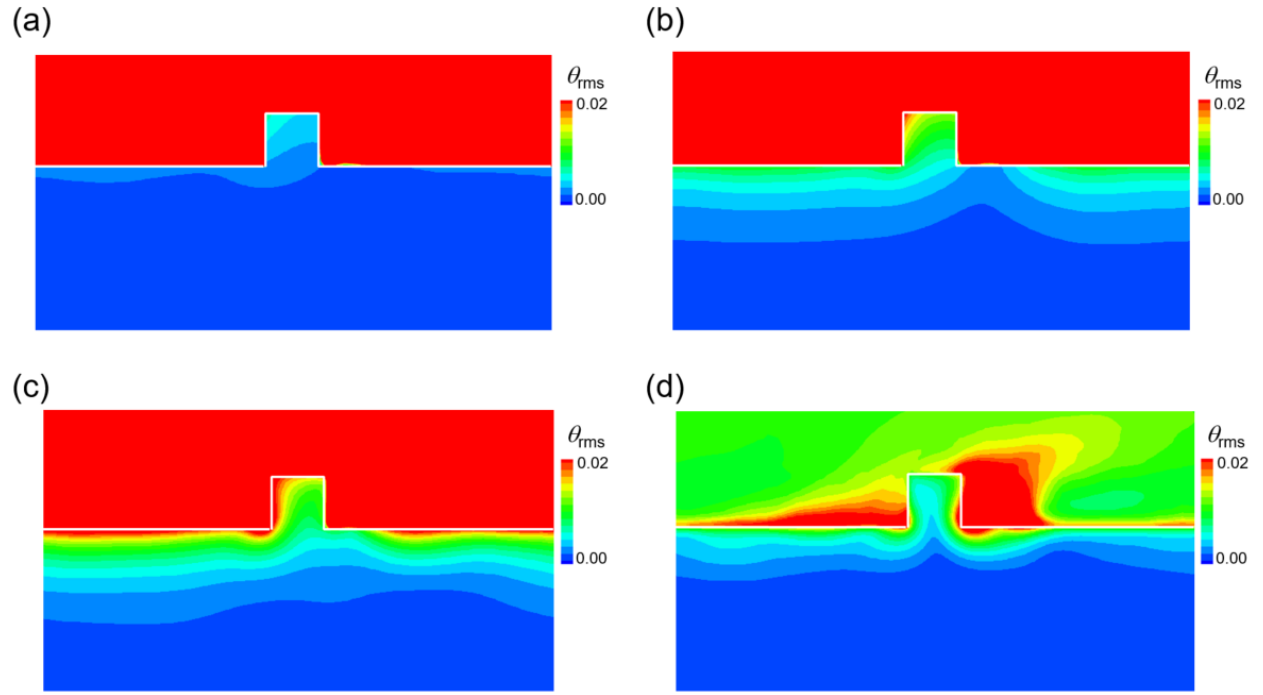
Figure 8. Temperature fluctuations ( θ rms ) for ( a ) K* = 566.26, ( b ) K* = 100.00, ( c ) K* = 10.00, and ( d ) K* = 1.00.